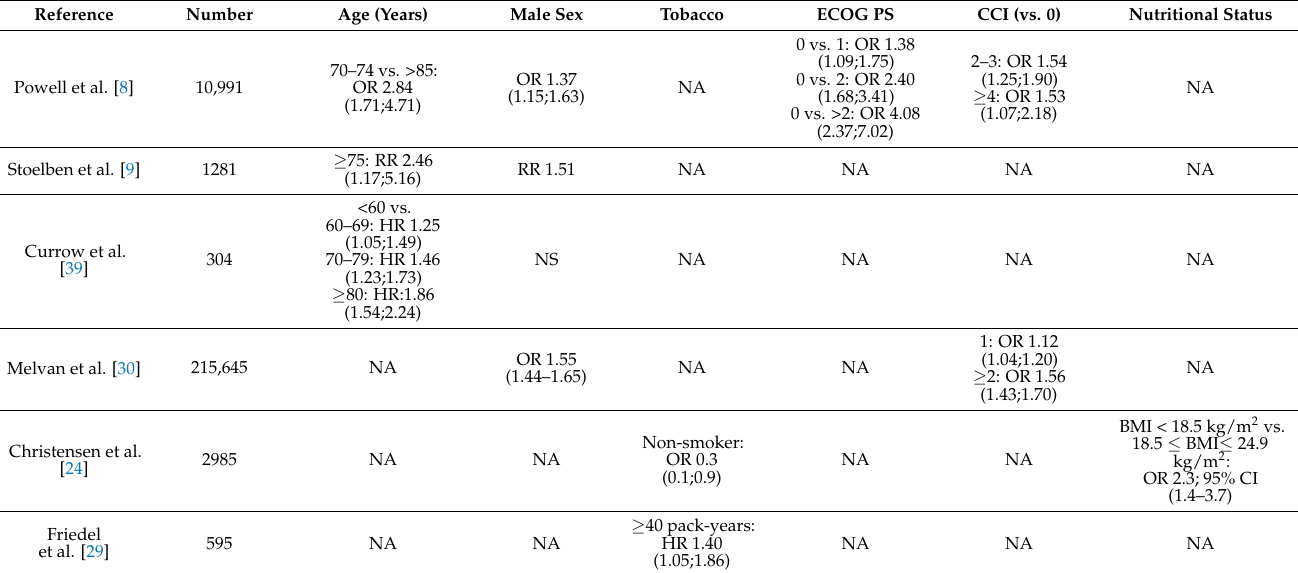
Table 1. Main clinical characteristics associated with early lung cancer death in resected early-stage NSCLC